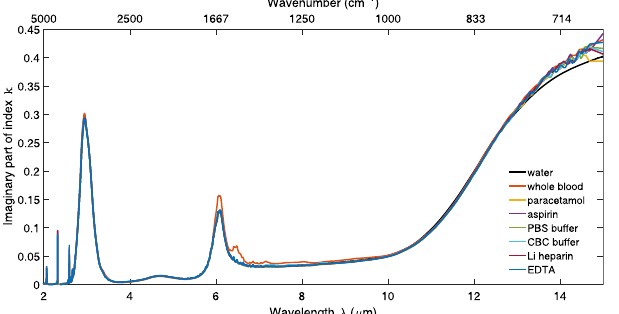
Figure 3. Imaginary part of refractive index spectra k( λ ) for whole blood and aqueous solutions of paracetamol, aspirin, heparin, EDTA, PBS and CBC.